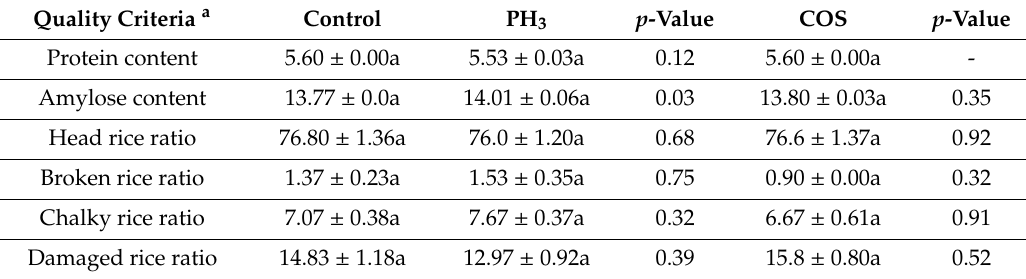
Table 3. Quality of rice exposed to 2 g / m 3 PH 3 and 50 g / m 3 COS at a 50% loading ratio following 48 h of exposure in a 0.5 m 3 fumigation chamber.